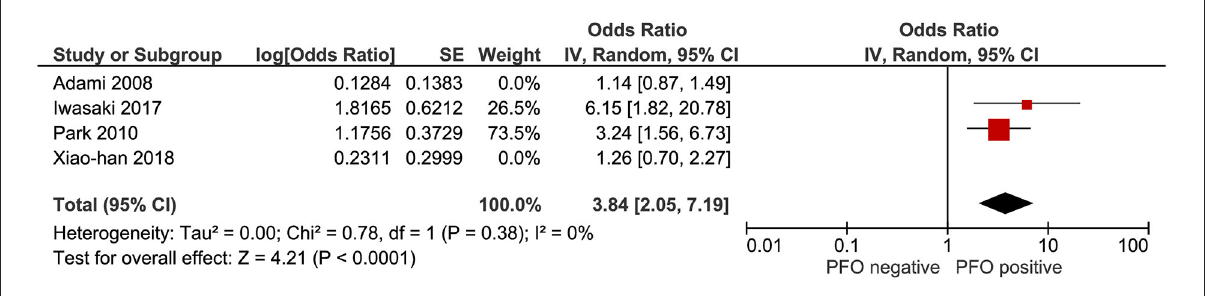
FIGURE3 Forest plot of the association of RLS with prevalence of WMH (adjusted odds